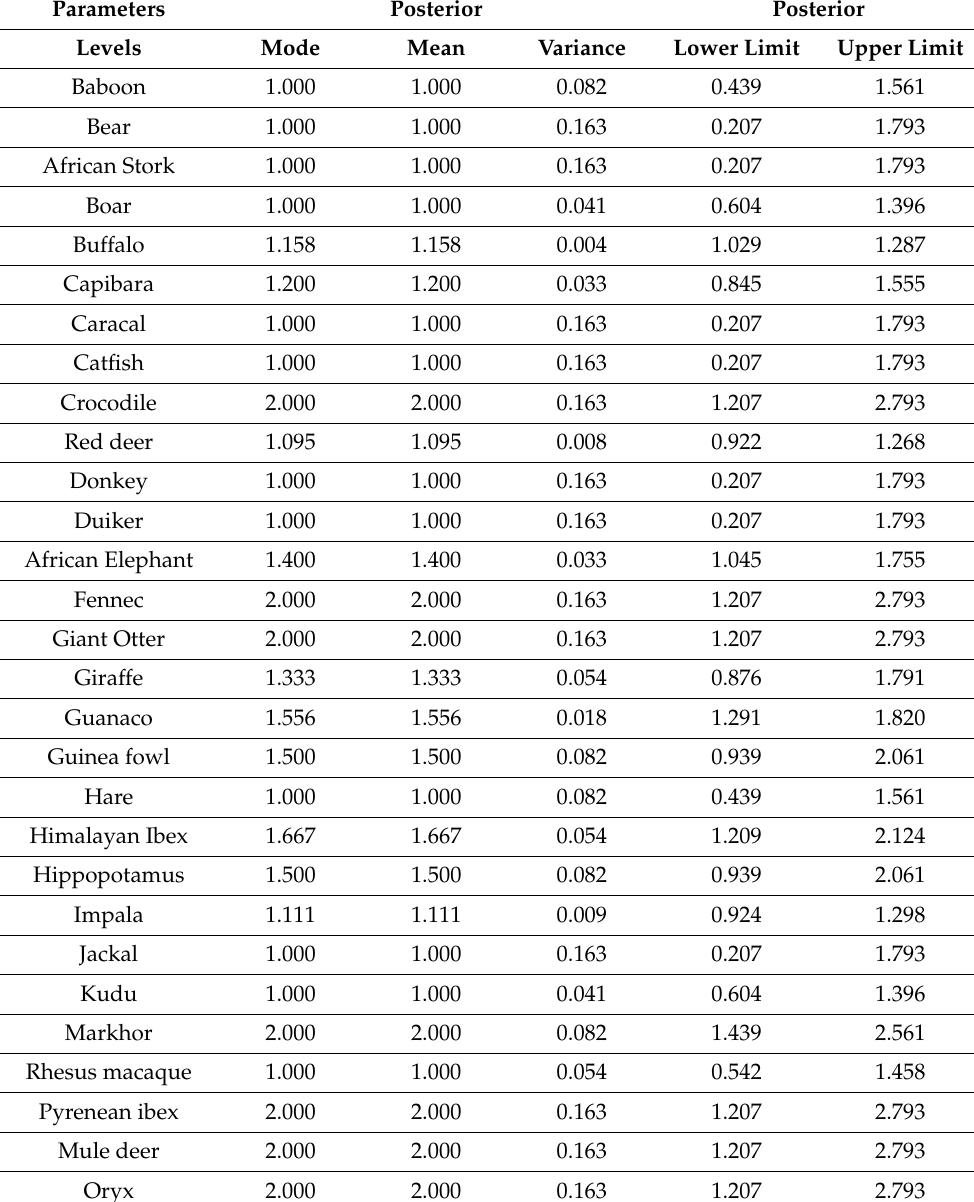
Table 6. Summary of the descriptive statistics of the posterior distribution for the prey species factor.